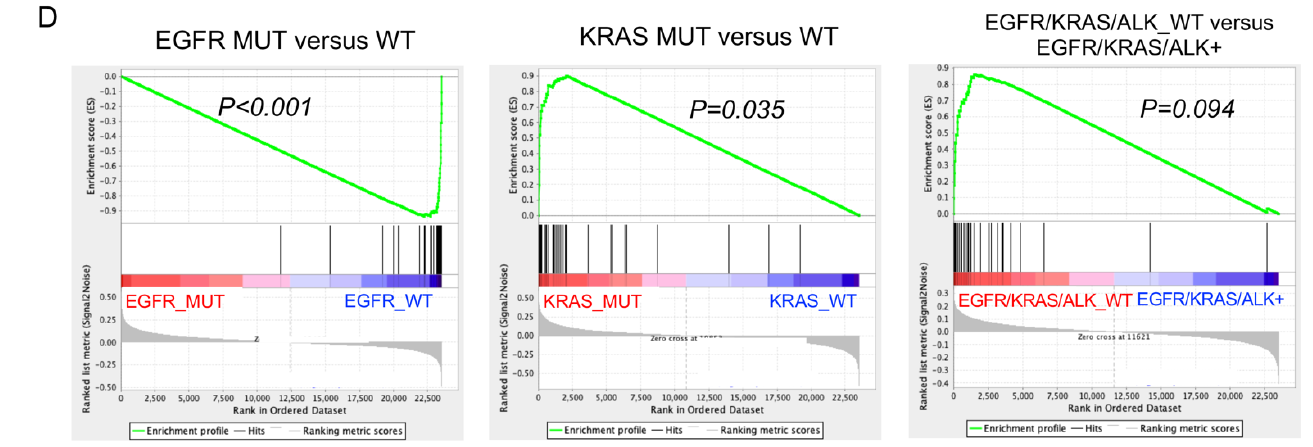
Figure 4. High MMP gene signature expression predicts poor survival outcomes in stage I lung adenocarcinoma from the GSE31210 cohort; 168 stage I lung adenocarcinoma patient samples from the GSE31210 cohort were analyzed: ( A ) An unsupervised hierarchical clustering heatmap revealed three lung adenocarcinoma subgroups clustered with the 36-gene MMP signature. ( B ) Kaplan–Meier survival analysis of patient subgroups based on the 36-gene MMP signature was performed using the log-rank test. ( C ) The distribution difference among the three subgroups stratified by gene mutation, gender, and smoking status was tested by the Chi-squared test. ( D ) GSEA showed the enrichment of 36-gene MMP signature based on mutation status in the GSE31210